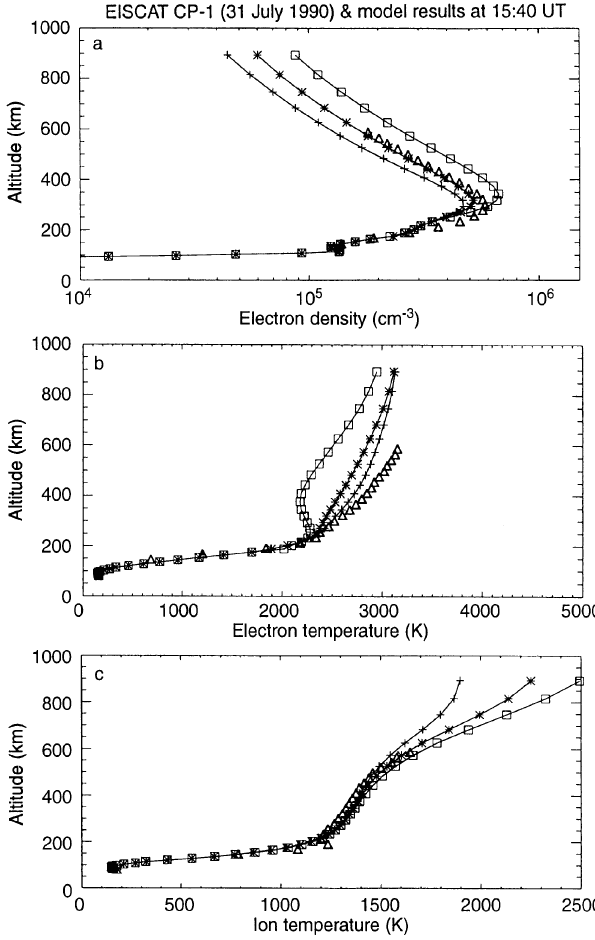
Fig. 8. As in Fig. 3, but illustrating the effect of different convection patterns during the afternoon overflight of Magion-2 (orbit 3812) around 1540 UT on 31 July 1990. Here, the variation of the vertical profiles above the EISCAT station are shown for different patterns of convection: maximum FACs in the 06 — 18-MLT meridional plane ( curves with crosses ), 08 — 20-MLT ( asterisks ) and 10 — 22 MLT ( squares